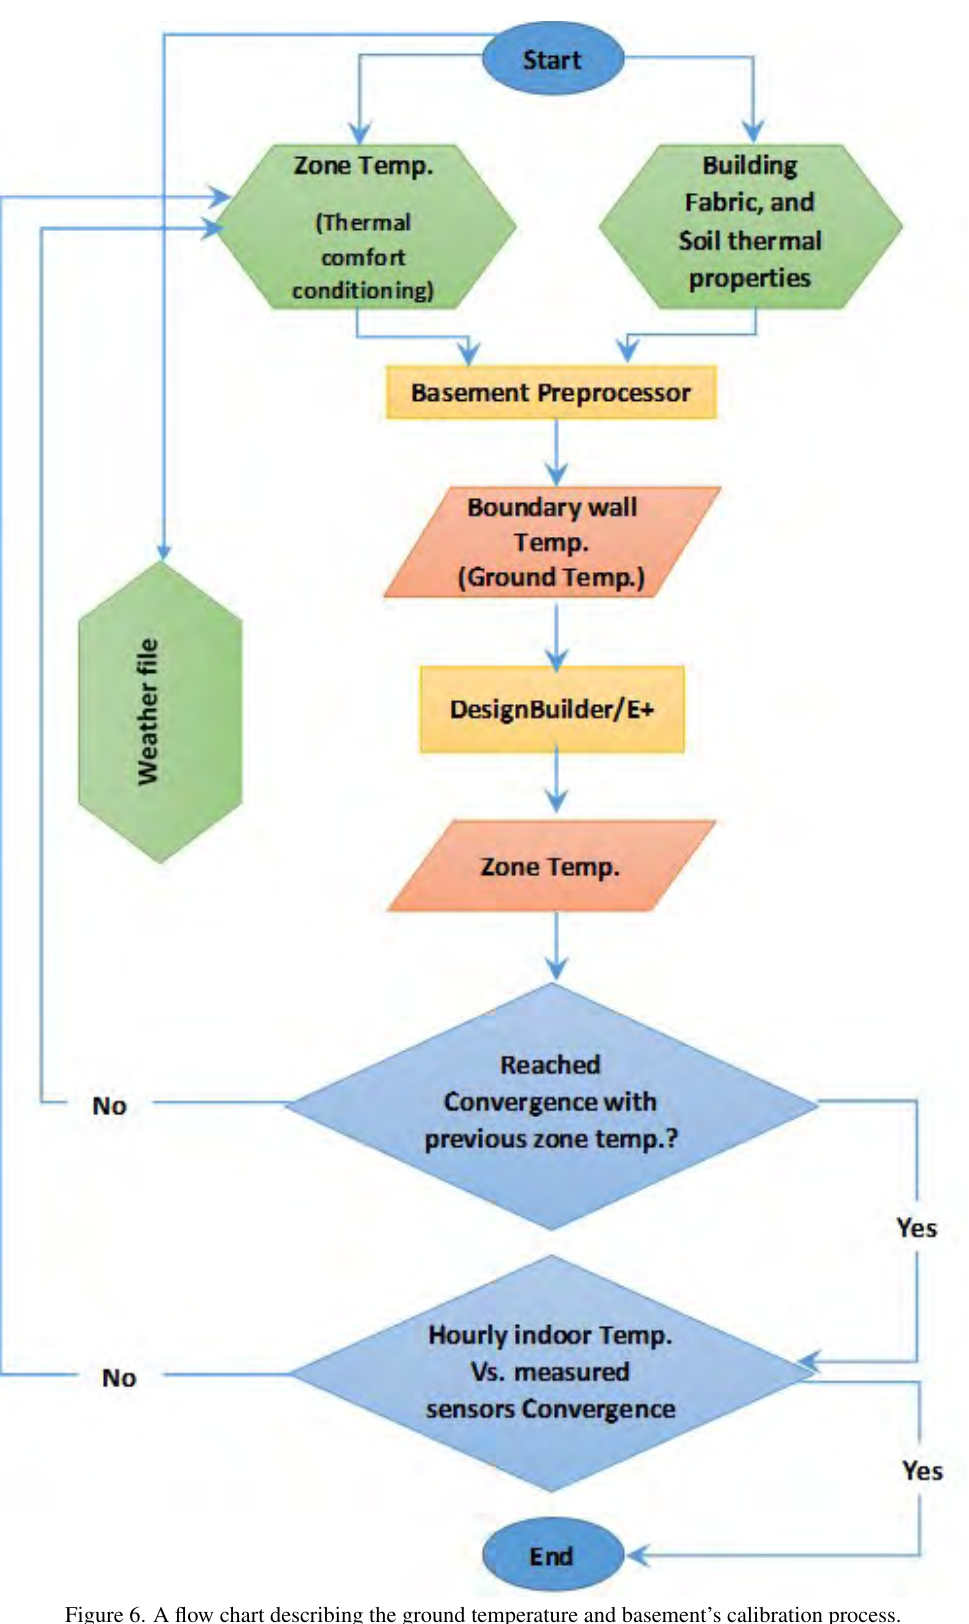
Figure 6. A flow chart describing the ground temperature and basement’s calibration process.